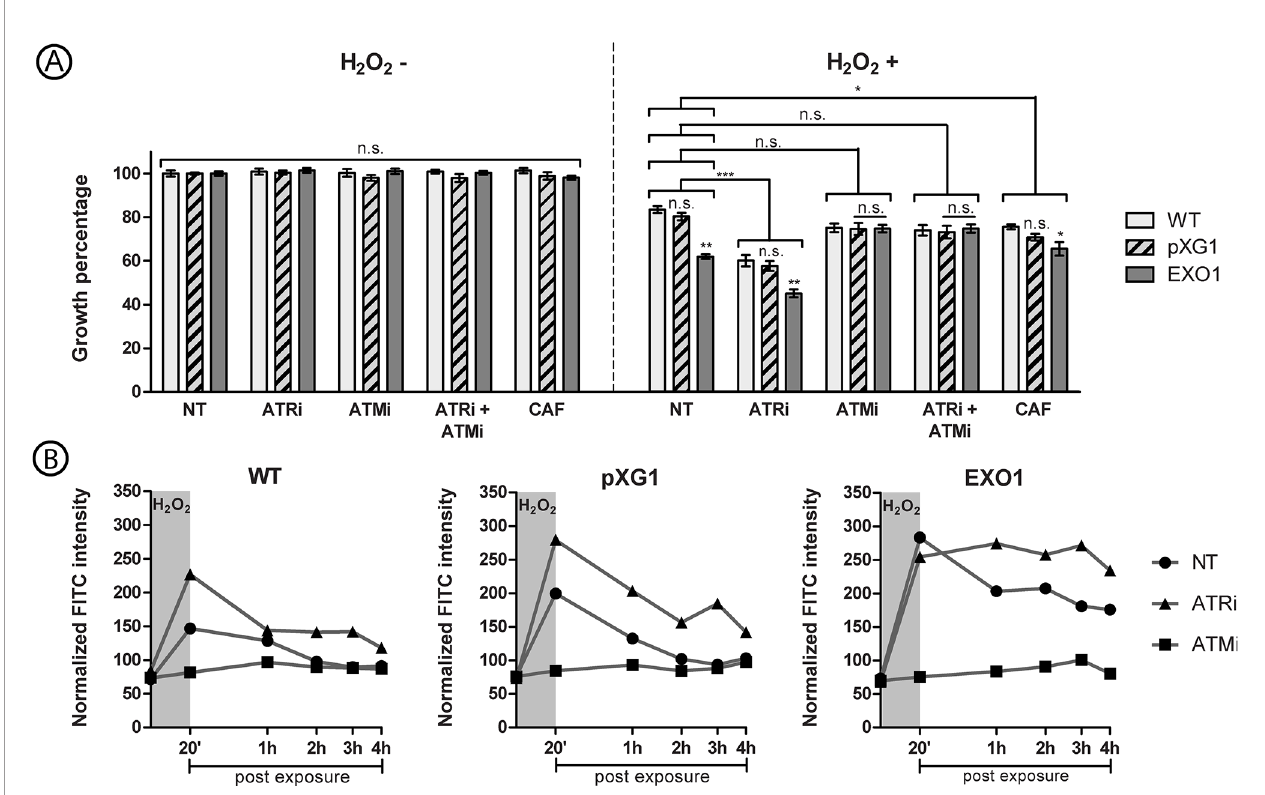
FIGURE 4 | Effect of ATR and ATM inhibitors in the growth and ssDNA formation of L. major lineages exposed to hydrogen peroxide. (A) The graph display percentage of growth of L. major wild-type (WT, light grey columns), episome vector control (pXG1, hatched columns) and LmjEXO1 overexpressor lineage (EXO1, dark grey columns), after exposure to hydrogen peroxide (H 2 O 2 ). The parasite cells were treated with 5 mM caffeine (CAF), 10 m M ATRi, 10 m M ATMi, or a combination of 10 m M ATRi and 10 m M ATMi, for 1 hour before the addition of H 2 O 2 .The parasites were then exposed to 500 m M H 2 O 2 for 20 minutes. Cells were counted after 72 hours. The growth percentage is relative to the one of parasites not treated and not exposed to H 2 O 2 of each lineage. The data represent mean ± standard error of three independent experiments, each one performed as triplicates. Two way analysis of variance (two-way ANOVA) is shown, and it includes the results of the post-hoc tests of Bonferroni (comparisons between lineages inside each treatment) and Dunnett (brackets comparing treatment groups). Control groups are the parasites not treated with inhibitors. *p < 0,05; **p < 0,005; ***p < 0,0005. (B) The curves exhibit the ssDNA formation kinetics in L. major wild type (WT), episome vector control (pXG1) e LmjEXO1 overexpressor lineage after the exposure to H 2 O 2 . Promastigote forms of L. major lineages were incubated during 1 hour in standard culture media (NT, circles) or media containing 10 m M ATRi (triangles) or 10 m M ATMi (squares). 500 m M H 2 O 2 were added to the cultures, which were then incubated for 20 minutes (darker area in the graphs). The parasites were washed for complete removal of the drugs and resuspended in standard culture media. 0,5 a 2×10 7 cells samples were collected 1 hour after the addition of inhibitors (starting point of the curves), after 20 minutes of the addition of H 2 O 2 , and then every hour after the removal of the drugs, until 4 hours post H 2 O 2 exposure. After cell fi xation, the parasites were incubated with anti-BrdU FITC conjugate for the detection of 5-IdU nucleotide. The mean fl uorescence intensity of parasites with a >10 2 UA fl uorescence intensity was normalized with the mean fl uorescence of parasites under that threshold. The histograms used for this quanti fi cation are presented in Supplementary Figure 6 . The data are representative of two independent experiments and are presented as means ± standard errors of the normalized fl uorescence intensities. n.s., not signi fi